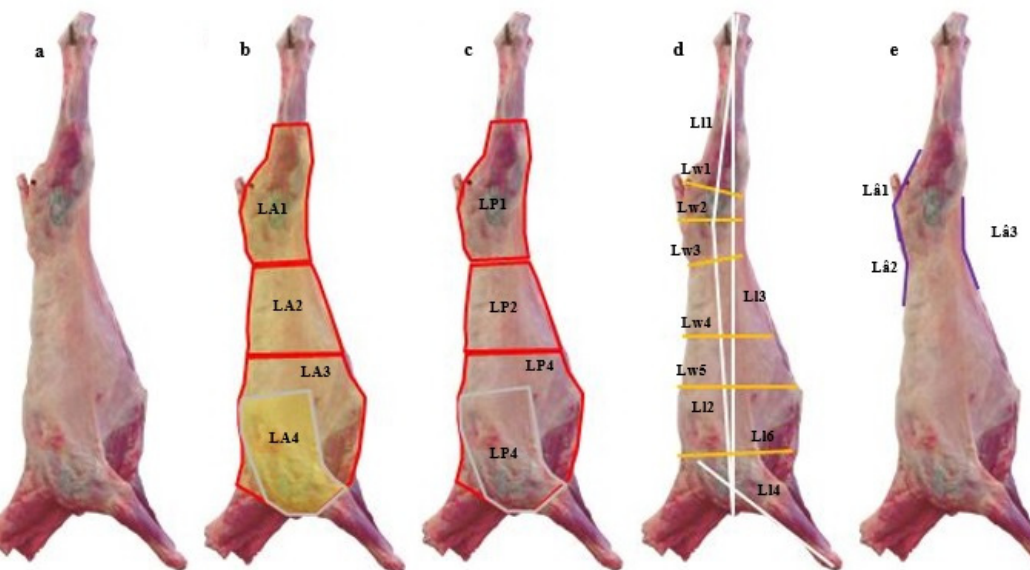
Figure 1. Outer side view of light lamb carcass in Churra da Terra Quente (CTQ) breed ( a ) depicting the descriptors used to collect measures of areas ( b ), perimeters ( c ), lengths and widths ( d ) and angles ( e ). LA1 = area of the leg; LA2 = area of the loin; LA3 = area of the forequarter; LA4 = area of the shoulder; LP1 = perimeter of the leg; LP2 = perimeter of the loin; LP3 = perimeter of the forequarter; LP4 = perimeter of the shoulder; Ll1 = length of the leg; Ll2 = thoracolumbar length; Ll3 = length between the calcaneus and the greater tubercle of humerus; Ll4 = length of the forearm; Lw1 = thinnest width of the leg; Lw2 = largest width of the leg; Lw3 = minimum waist width; Lw4 = maximum waist width; Lw5 = maximum thoracic width; Ll6 = widest part of the chest; Lâ1 = leg angle; Lâ2 = leg angle; Lâ3 = leg angle.